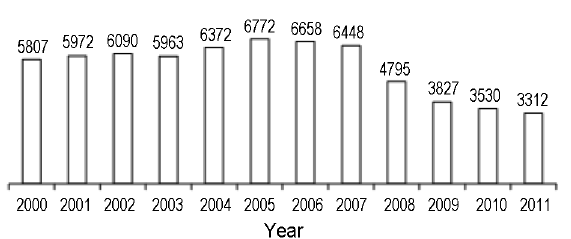
Fig. 2. The dynamics of traffic accidents registered by the Traf- fic Police of Lithuania in 2000–2011